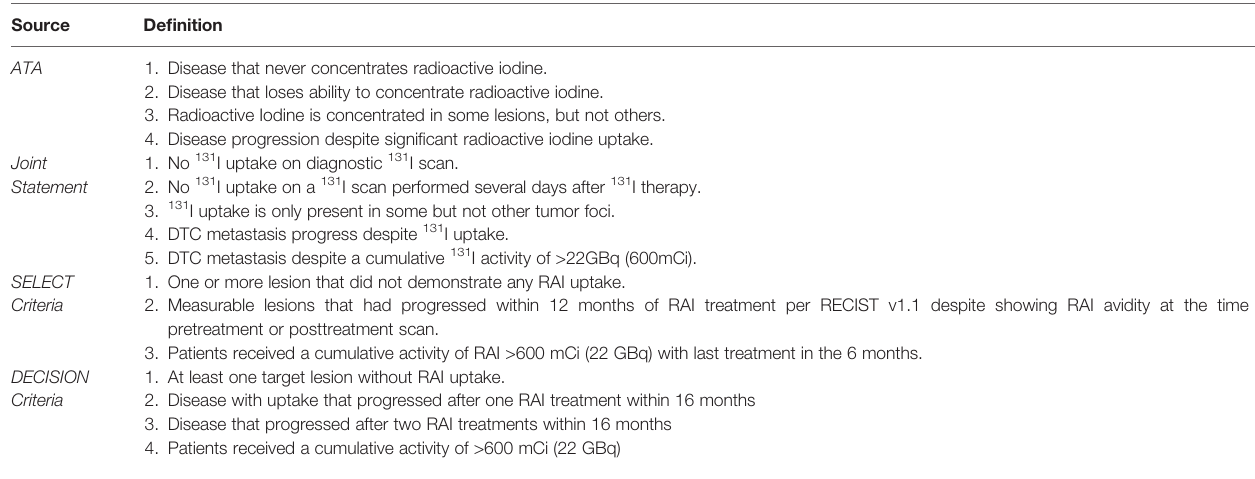
TABLE 1 | Iodine Refractory Differentiated Thyroid Cancer De fi